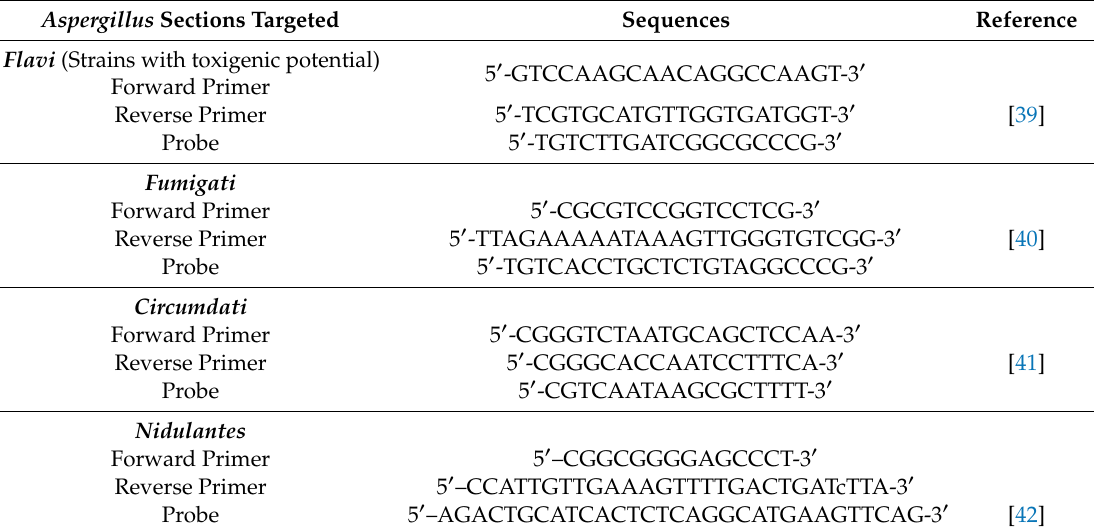
Table 1. Sequence of primers and TaqMan probes used for real-time PCR. Aspergillus Sections Targeted Sequences